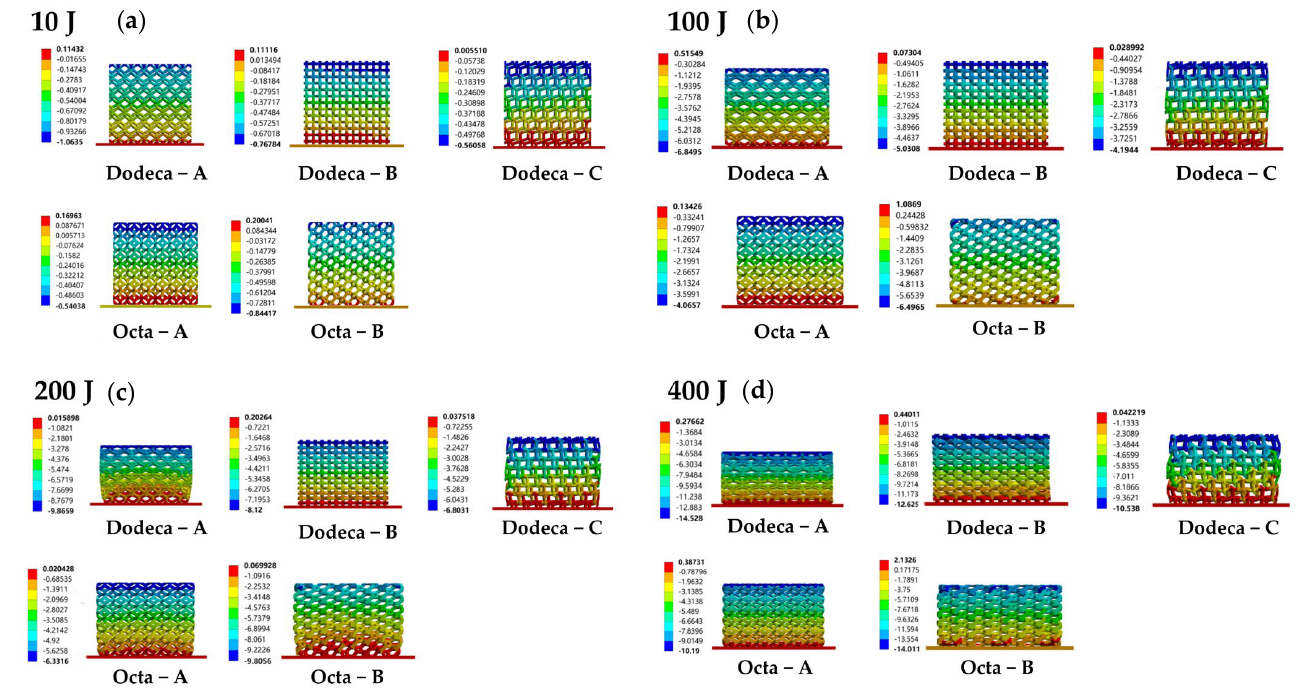
Figure 8. Comparison of deformation modes of 80%-porosity structures at different impact energies: